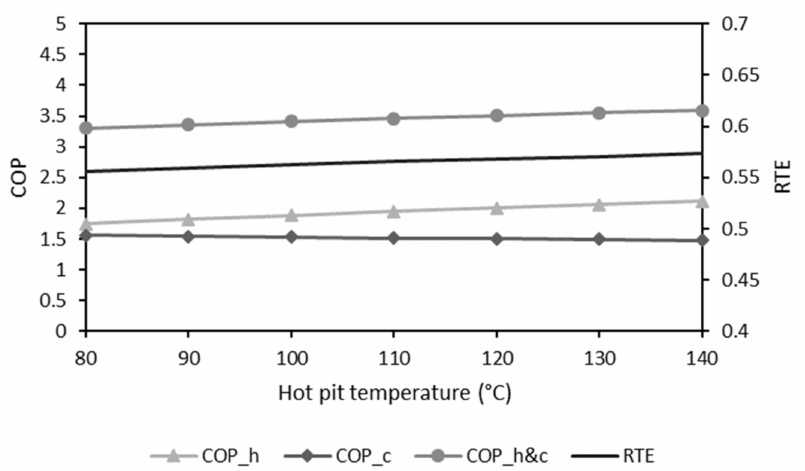
Figure 4. Evolutions of COP depending on hot pit temperature.